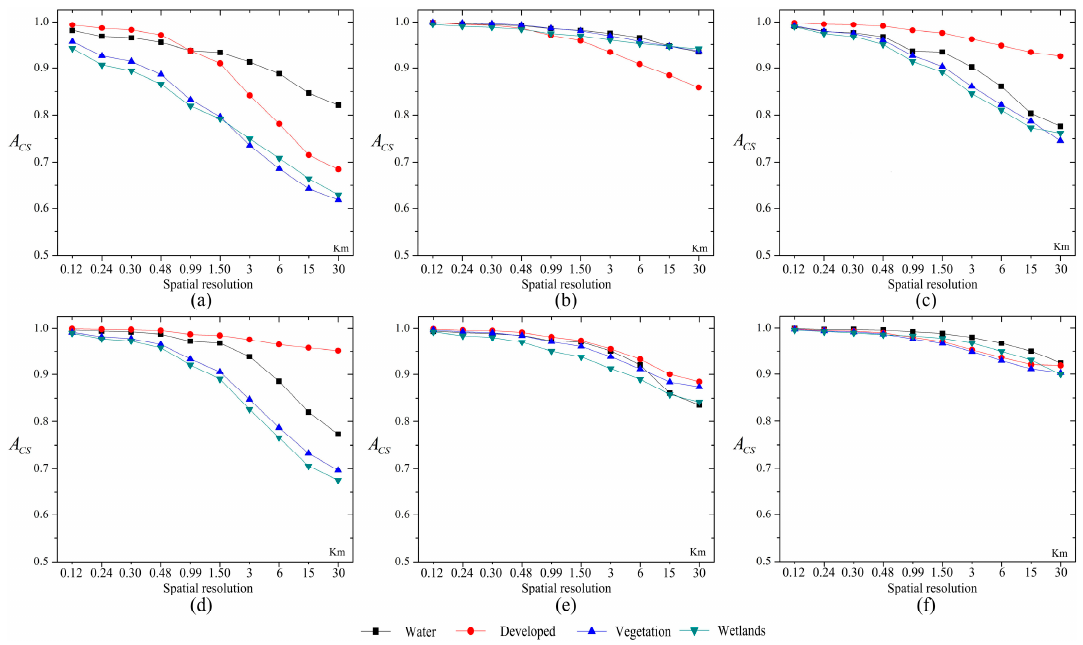
Figure 11. The A cs values during 2001–2011 for different land cover classes with the four-class scheme. ( a – f ) Represent the results of the study areas A to F, respectively.